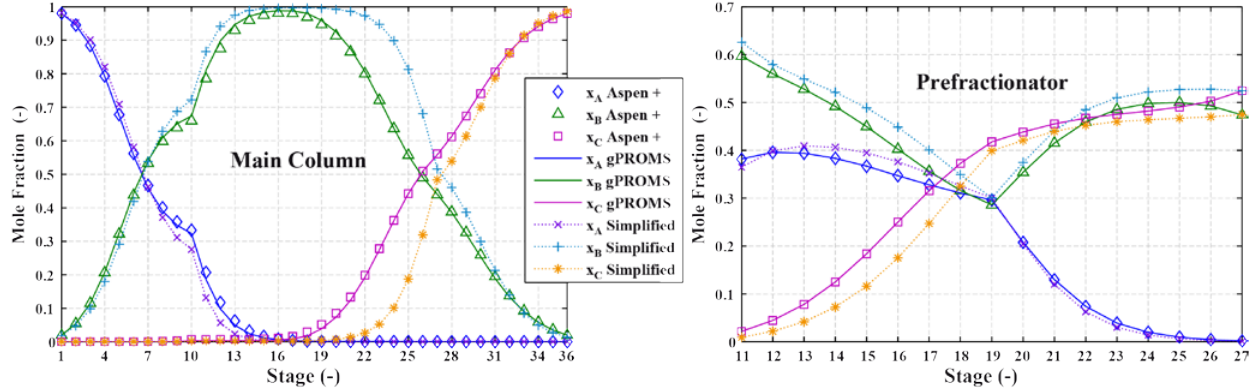
Figure 3. Comparison of liquid composition profiles of the main column and of the prefractionator computed by the gPROMS model, an Aspen Plus model, and a simplified model from the